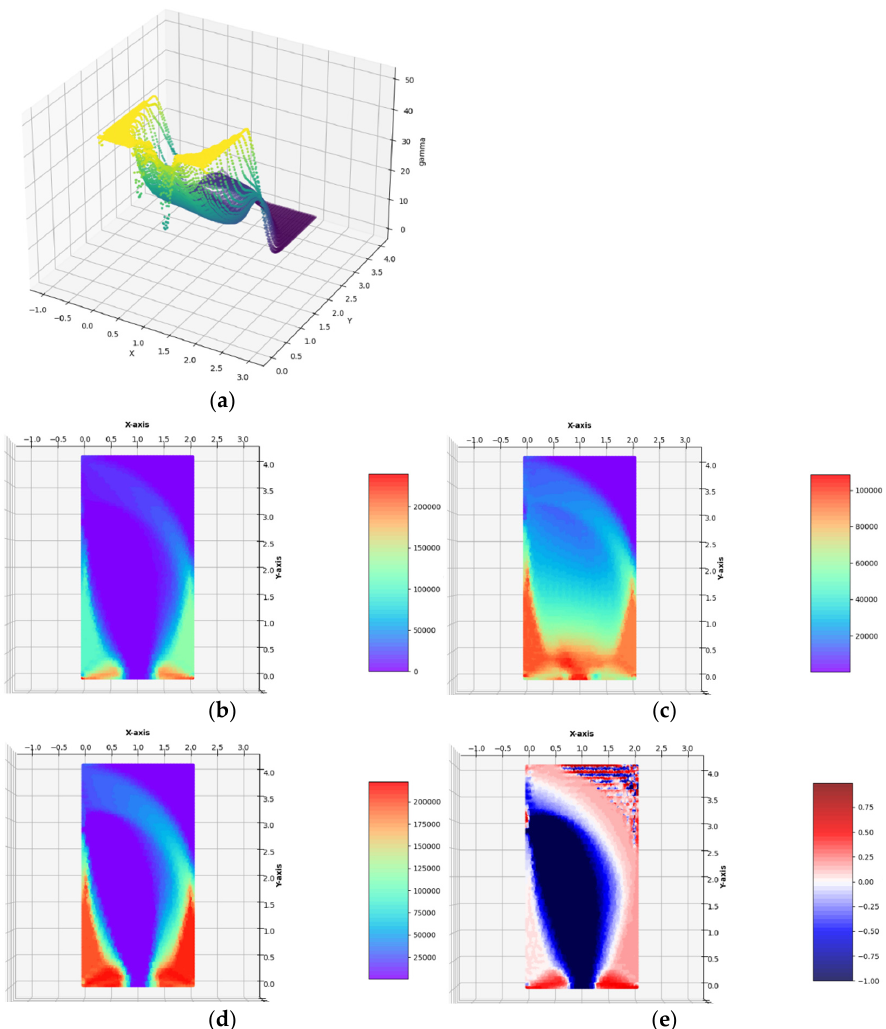
Figure 10. Optimal solutions of the problem of Example 1c. ( a ) The plot of the γ function, ( b ) bulk modulus k * / b , ( c ) shear modulus µ * / b , ( d ) Young’s modulus E * / b , ( e ) Poisson’s ratio ν * in the case of FEM mesh composed of quadrilateral elements.